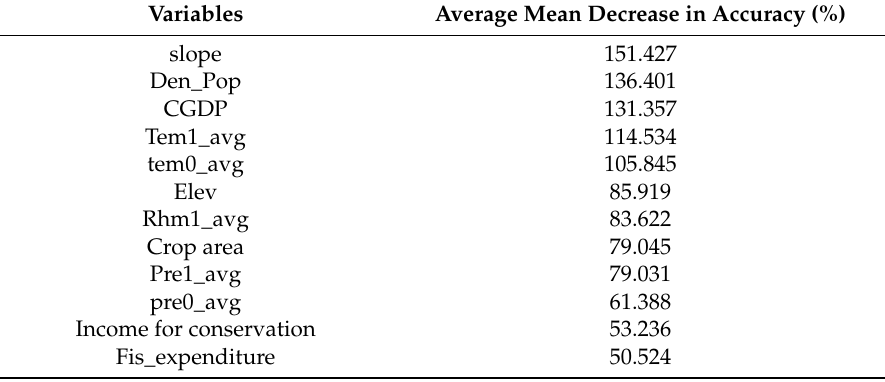
Table 5. Variables that were included in the final model and the ranking of importance of variables (descending order) based on average % IncMSE from the five samples. Note: the variable name refers to Table 1.